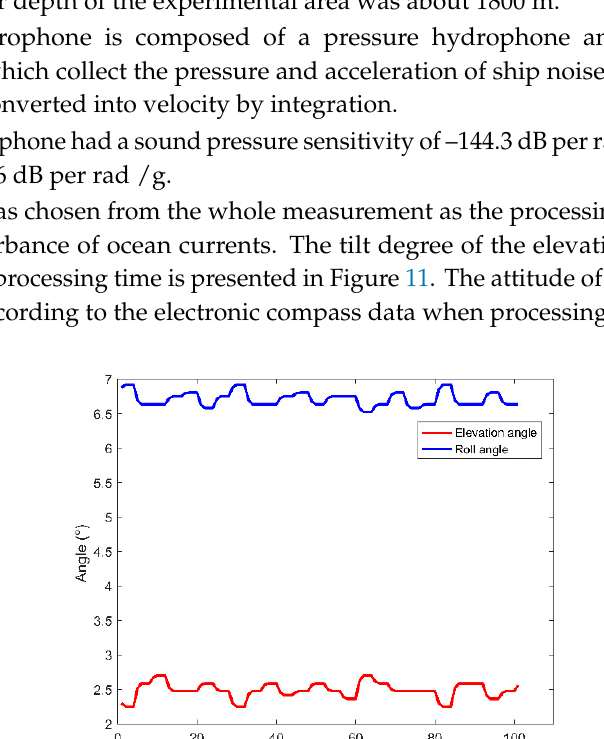
Figure 11. The tilt degree of elevation angle and roll angle during the 100 s processing time.